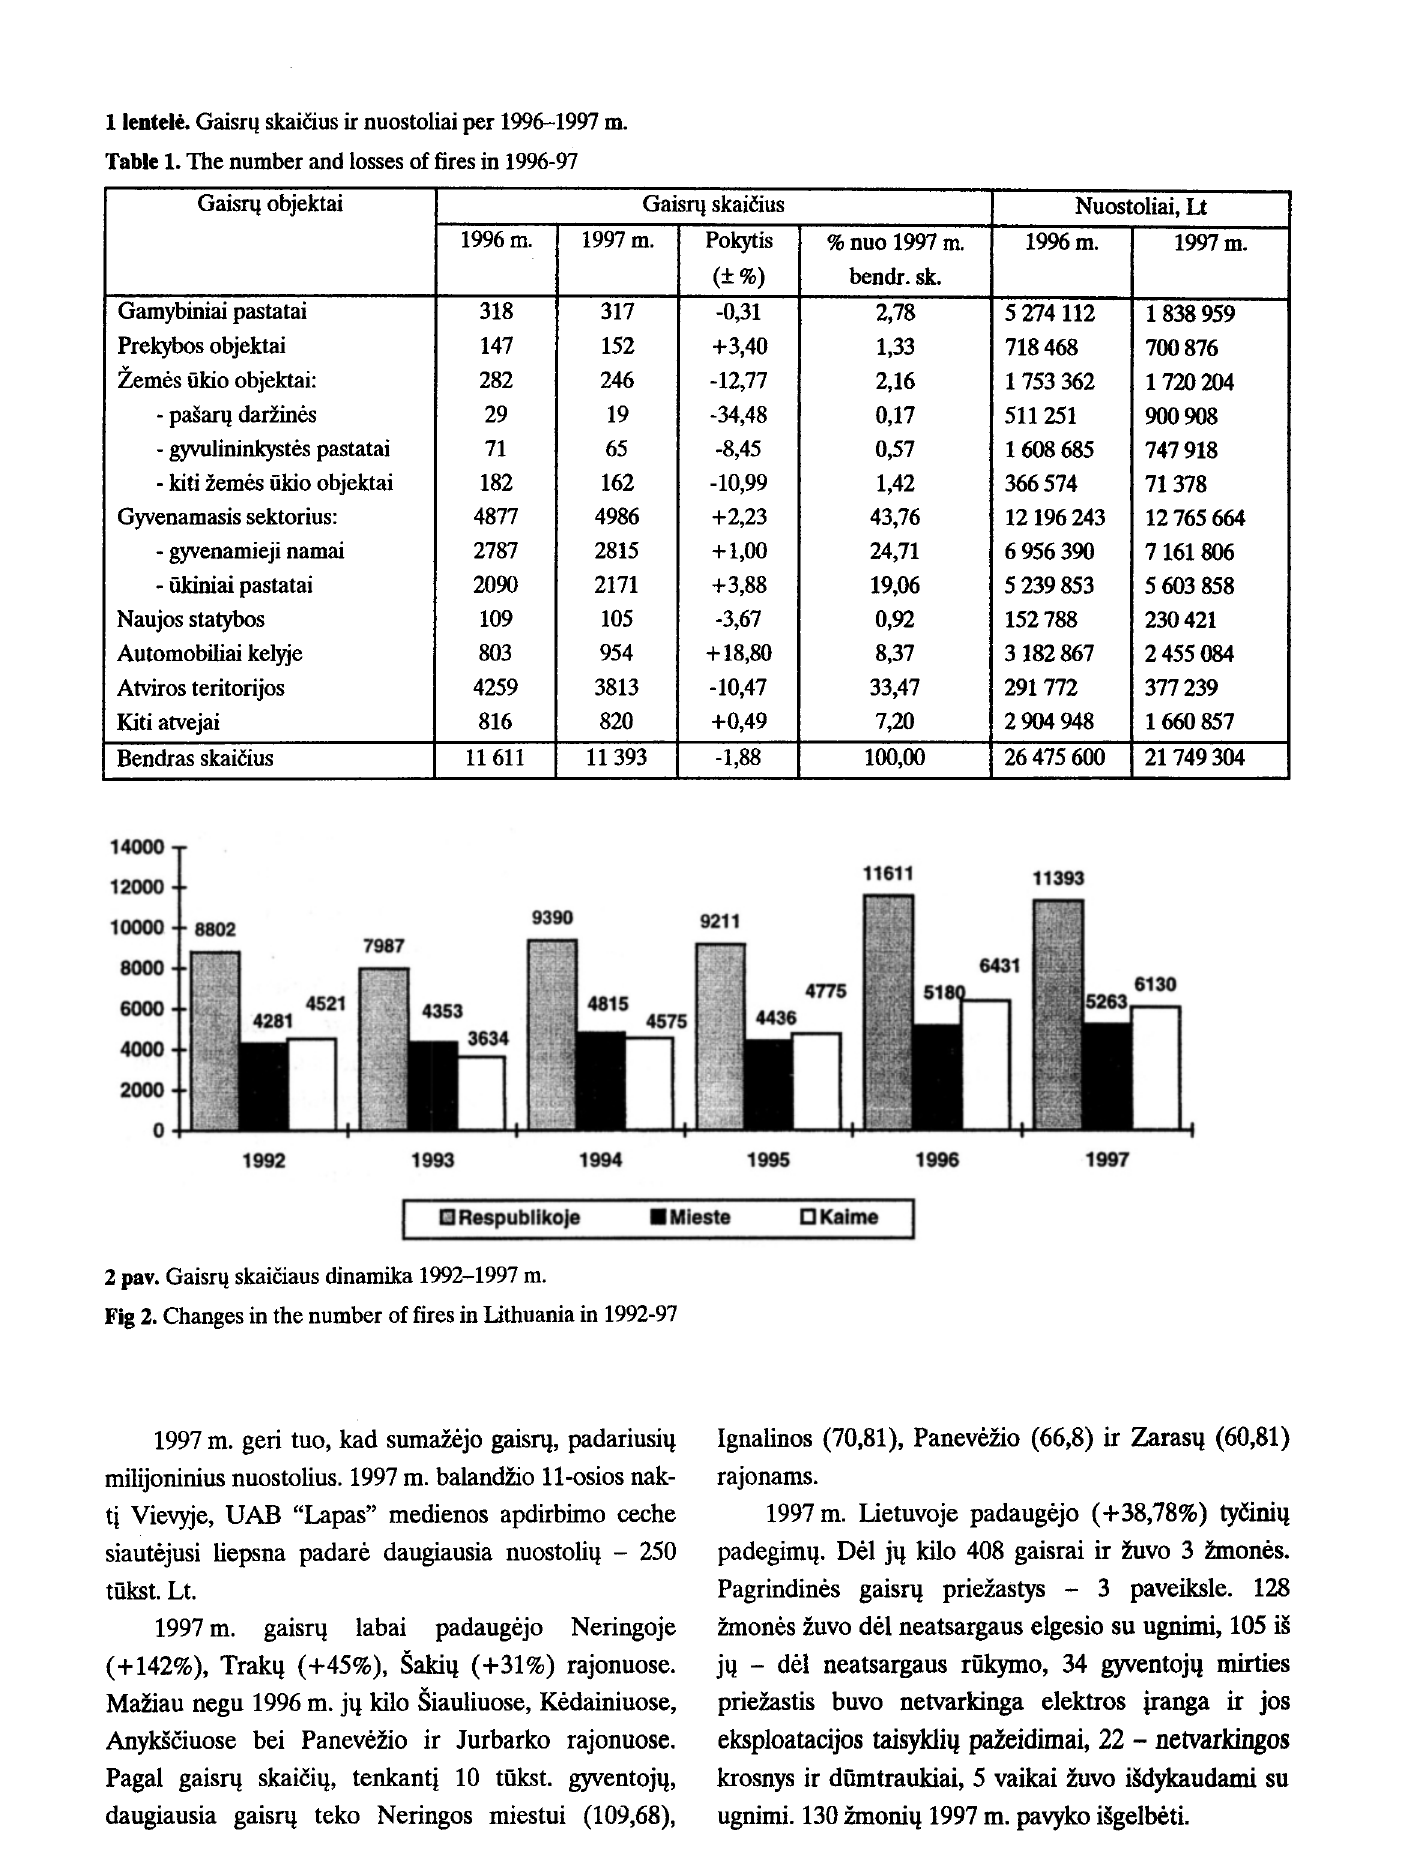
Fig 2. Changes in the number of fires in Lithuania in